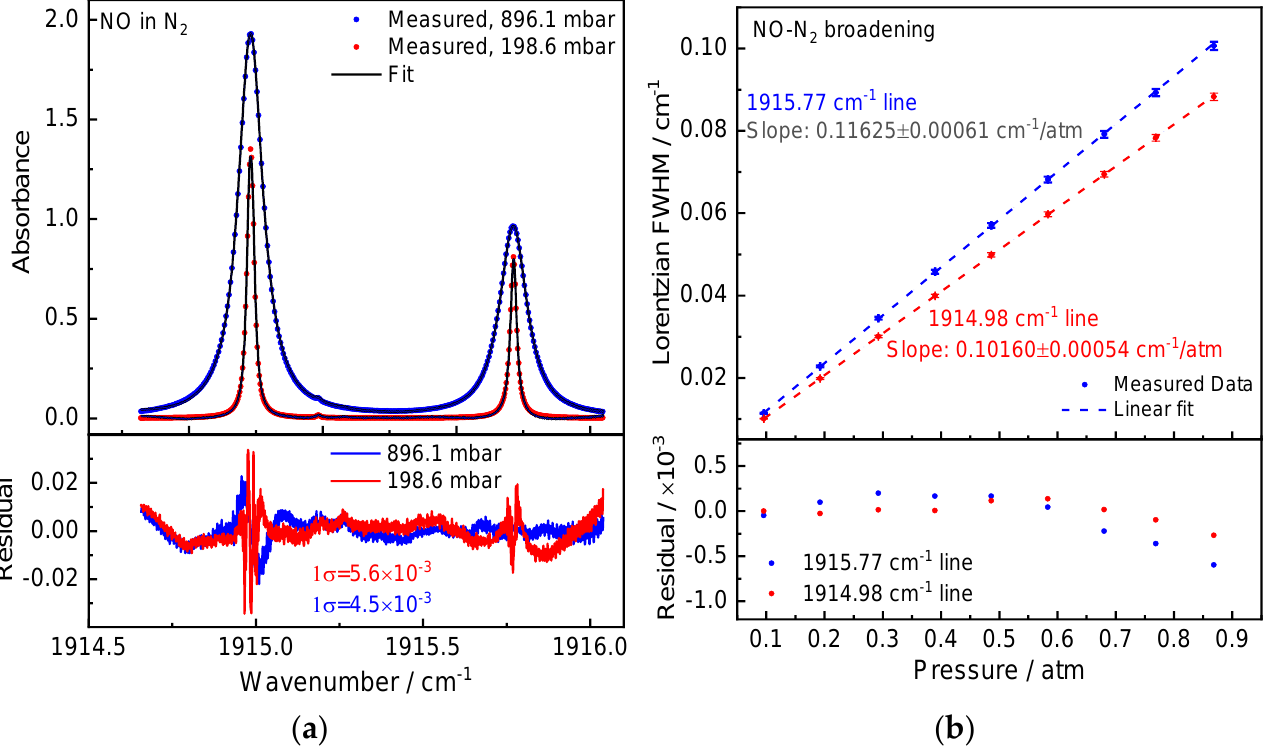
Figure 3. ( a ) Measured NO absorption spectra in N2 at pressures of 896.1 mbar and 198.6 mbar (20-scan averaged). The residual between the measured and fitted data is depicted below, yielding an SNR of ~300. ( b ) Experimentally obtained N 2 -induced pressure broadening of the NO absorption lines with a linear fitting model. The residual between fit and data is depicted in the graph below.